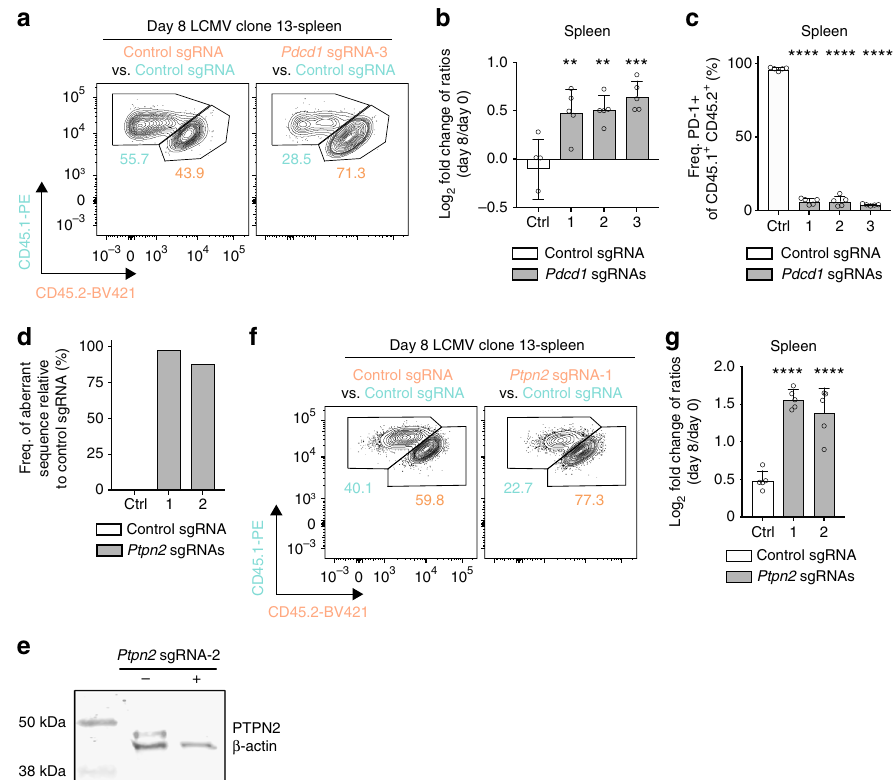
Fig. 5 Pdcd1 and Ptpn2 are negative regulators of CD8 + T cell responses to LCMV. a Representative output fl ow cytometry plots of P14 T cells containing control sgRNA vs. control or Pdcd1 sgRNAs in the spleen day 8 post LCMV Clone 13 viral infection. b Quanti fi cation of (a) with normalization of the output fl ow cytometry plots to the input ratios at day 0 and log fi cation of PD-1 expression on P14 T cells containing 2 transformation of the data. c Quanti